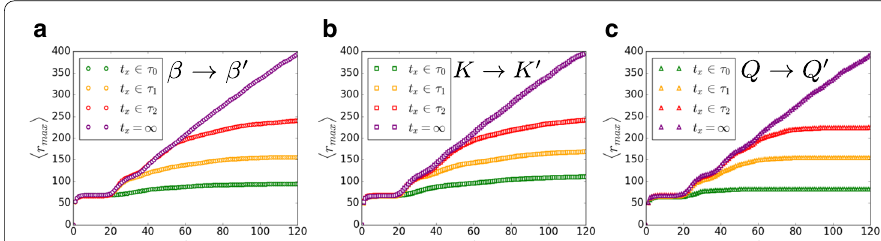
Fig. 5 Intervention timing. Here we show the effect of different control strategies performed at intervention timing t x at different circles’ timescales corresponding to Fig. 4 and compare them to the scenario of no intervention corresponding to the case of t x = ∞ . The epidemic start spreading with the parameters ζ = 100 , K = 4 , k inter = 10 − 3 , Q = 10 , L = 1000 and β = β c = 0.407 . a Social strategy. β → β ′ = 0.3 . b Quarantine strategy within cities. K → K ′ = 3 . c Quarantine strategy between cities. Q → Q ′ = 1 by reducing k inter → k ′ inter = 10 − 4 and keeping ζ fixed. The epidemic extent at t x is (cid:31) r max (cid:30) x and when the epidemic stops to spread it is (cid:31) r max (cid:30) f . In all cases the intervention successfully stop the disease spatial propagation with � r max � f ≈ � r max �